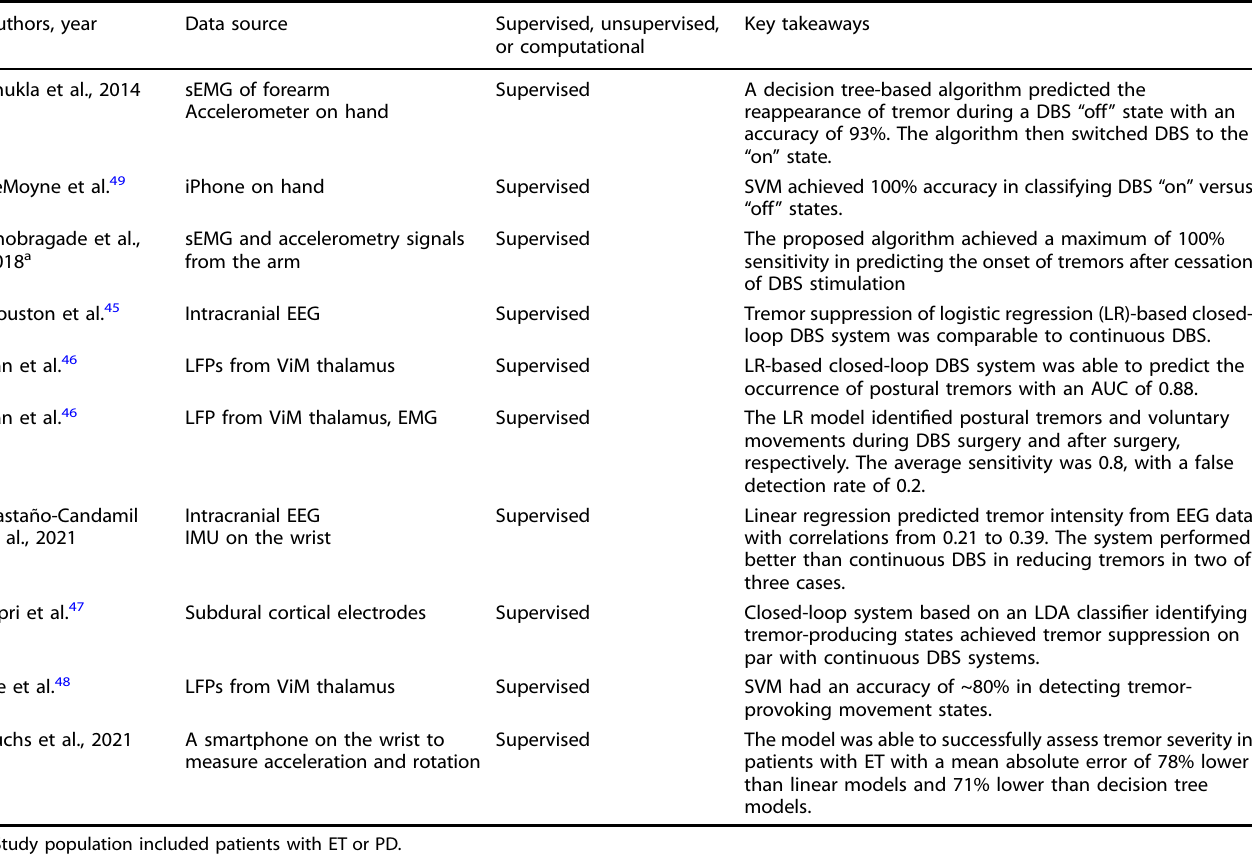
Table 4. Studies assessing the use of ML to develop closed-loop systems for ET. Logistic regression has commonly been used when analyzing ET. Many closed-loop systems achieved tremor suppression equivalent to traditional